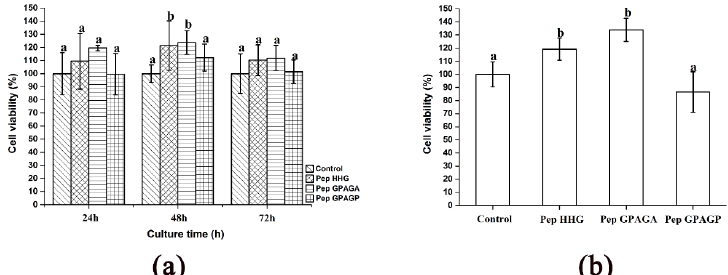
Figure 2. The relative cell viability of MC3T3-E1 osteoblast cells in response to Pep HHG, Pep GPAGA, and Pep GPAGP was measured using 3-(4,5-Dimethylthiazol-2-yl)-2,5-diphenyltetrazolium bromide (MTT) and CCK8 assays. ( a ) MTT assay results at 24, 48, and 72 h. ( b ) CCK8 assay results after 48 h. Different letters represent significant differences between groups, p < 0.05 Pep HHG: peptide HHGDQGAPGAVGPAGPRGPAGPSGPAGKDGR (Deamidation); Pep GPAGP: peptide GPAGANGDRGEAGPAGPAGPAGPR (Deamidation); Pep GPAGP: peptide GPAGPSGPAGKDGR.